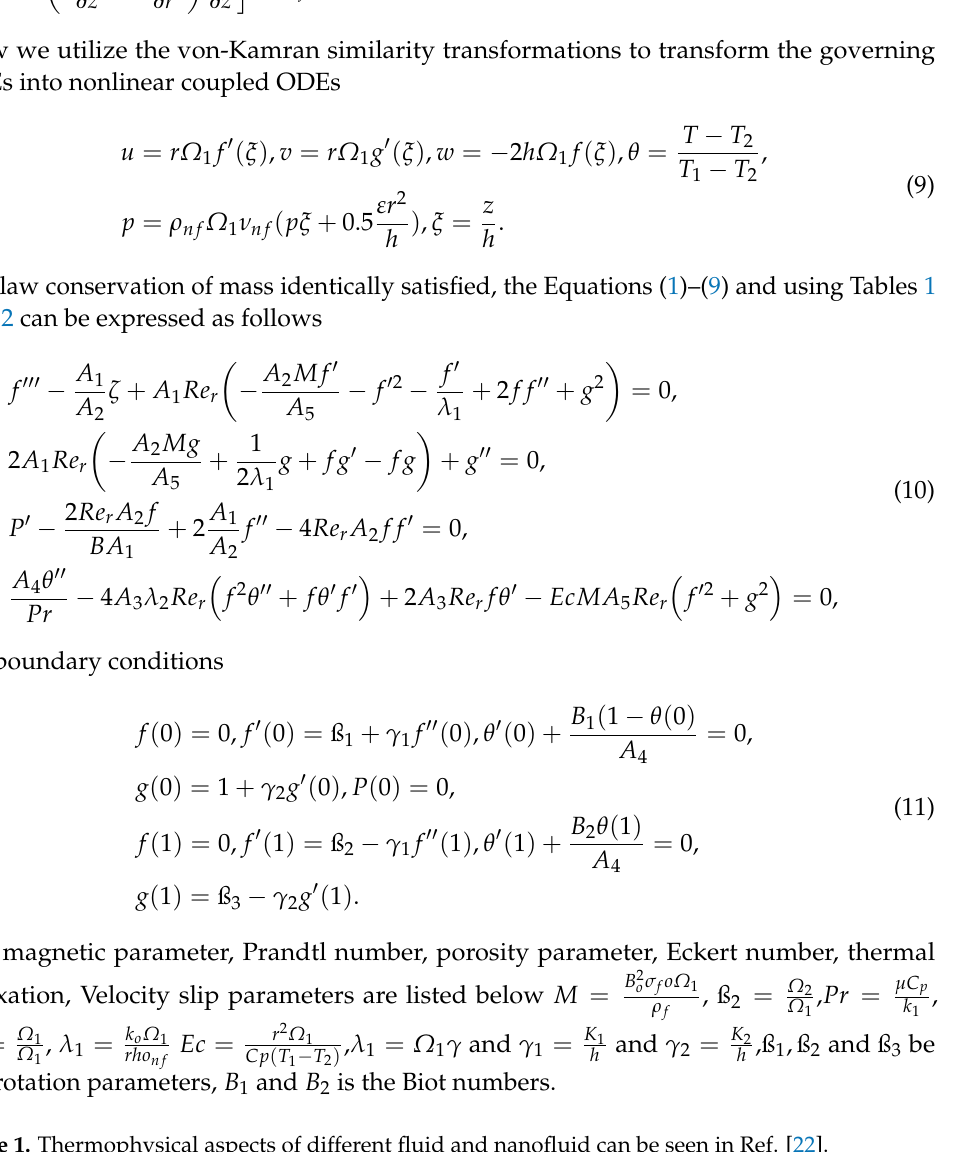
Table 1. Thermophysical aspects of different fluid and nanofluid can be seen in Ref. [22].